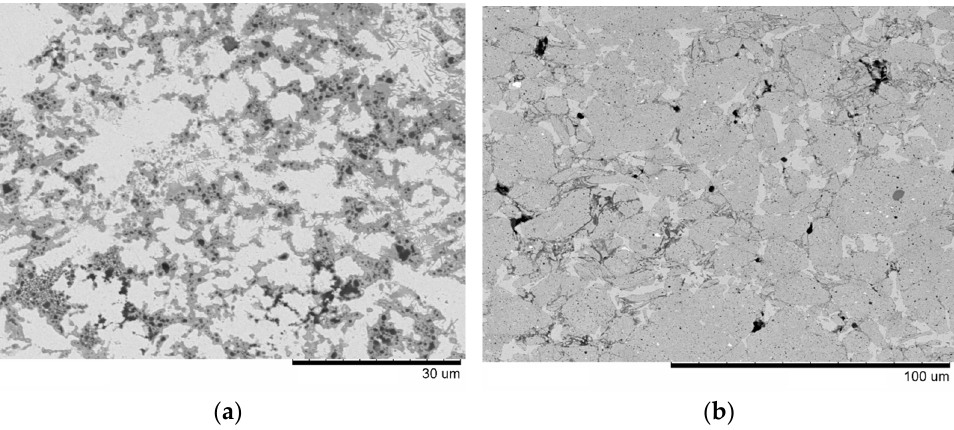
Figure 11. Microstructure (BSE images) of TiC-Cu composites formed by spark plasma sintering (SPS) of a non-milled Ti-C-3Cu mixture ( a ), a mixture subjected to HEBM for 10 min ( b ). Reprinted from [38], Copyright (2021), with permission from Elsevier.